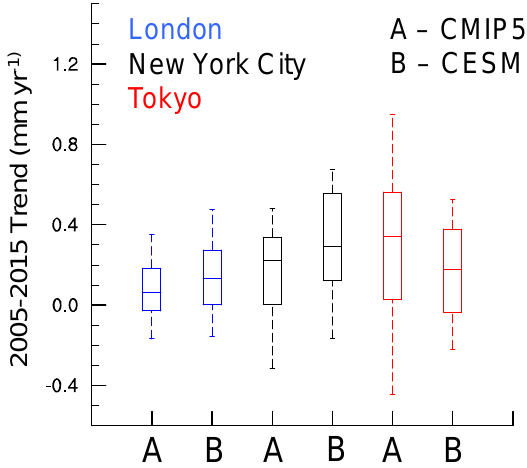
Figure 7. Box plots of steric sea-level trends over the full ocean column for three coastal locations. Notches from top to bottom represent 95% quantile, 75% quantile, median, 25% quantile, 5% quantile. Latitude and Longitudes used to calculate each set are as follows: London: 45–49 ◦ N, 346–6 ◦ E; Tokyo: 30–40 ◦ N, 134–145 ◦ E; New York City: 33–46 ◦ N, 280–290 ◦ E.